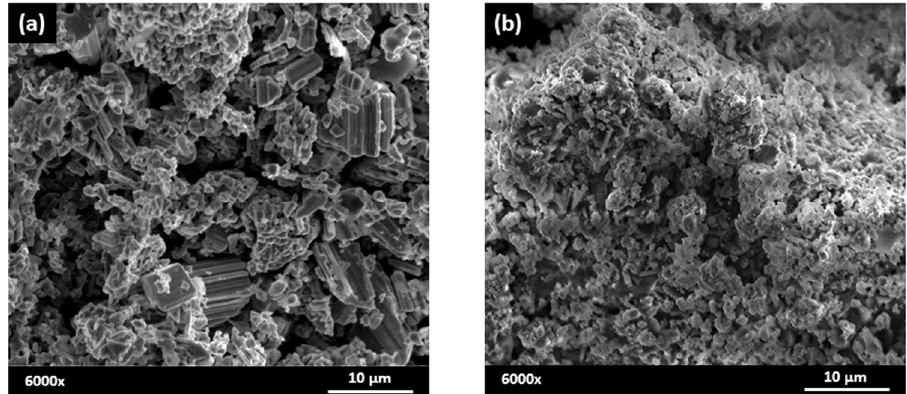
Figure 3. SEM micrograph of mixture powders: ( a ) 0 h BM and 12 h BM ( b